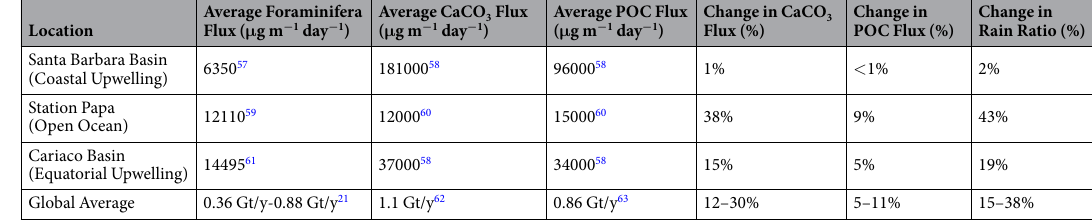
Table 1. Potential changes in foraminiferal contribution to CaCO 3 and POC flux, and the ‘rain ratio’. Fluxes are taken from the deepest available published sediment-trap measurements at each site for Santa Barbara Basin (500 m) in the Southern California Current System, Station Papa (1000 m) in the North Pacific, and Cariaco Basin (1200 m) in the tropical Atlantic 56–61 . Global averages assume a depth of > 1000 m and are based on a range of potential contributions of foraminifera calcite to CaCO 3 flux at depth 21, 61–63